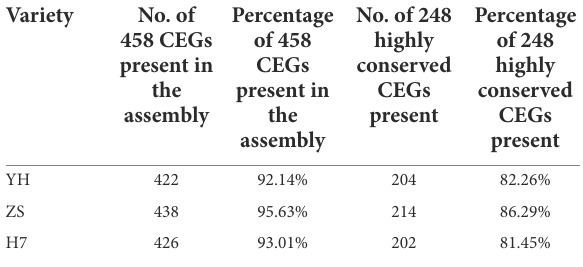
TABLE 2 Assessment of the integrity of core genes in the three Chinese chestnut varieties.